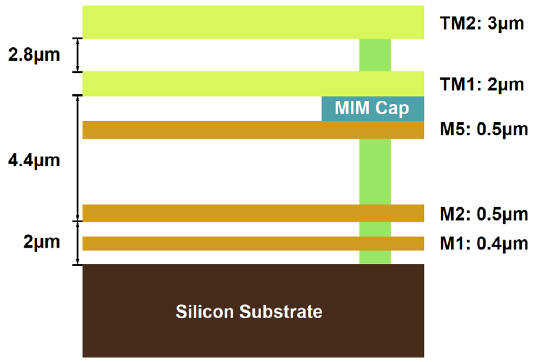
Figure 18. The structural diagram of 0.13 μm on-chip SiGe process.